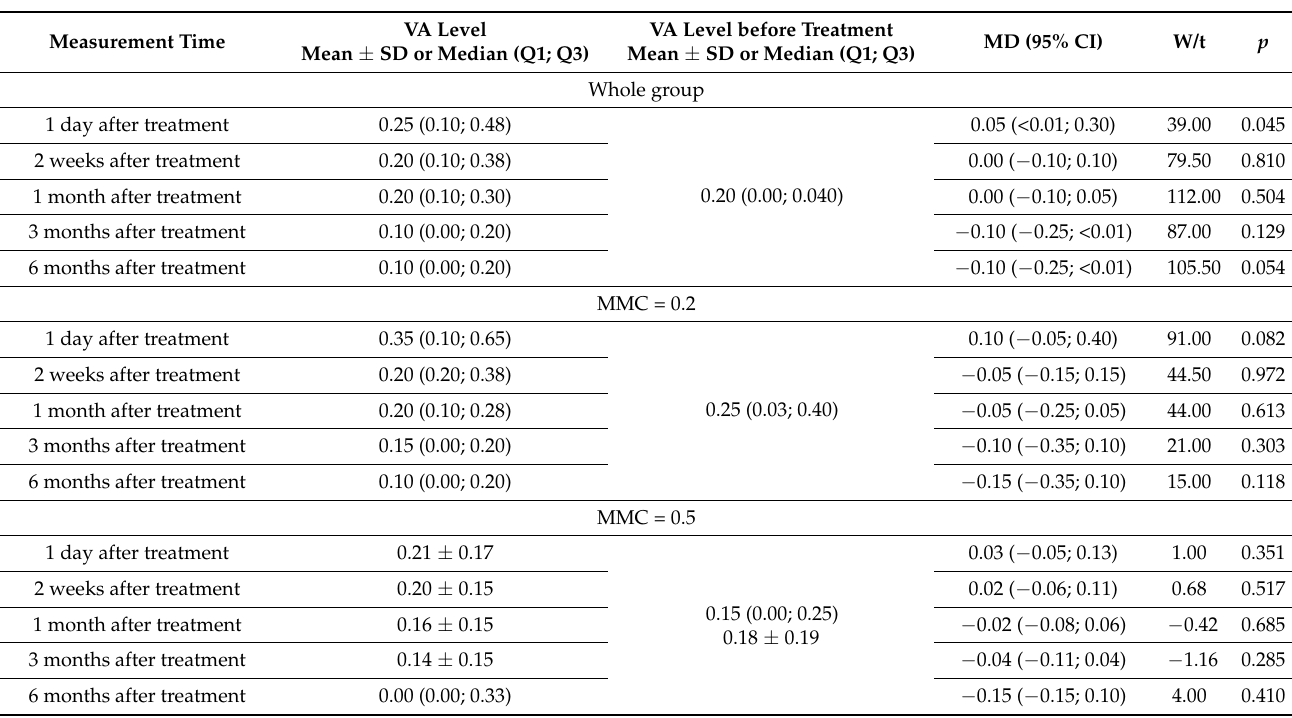
Table 2. Comparison between BCVA level before treatment and BCVA level 1 day, 2 weeks, 1 month, 3 months, and 6 months after treatment (in the whole group, in the group of people with MMC = 0.5 and MMC = 0.2).